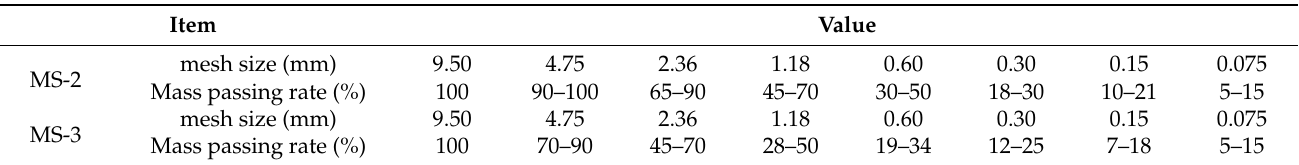
Table 3. Parameters of emulsified asphalt.